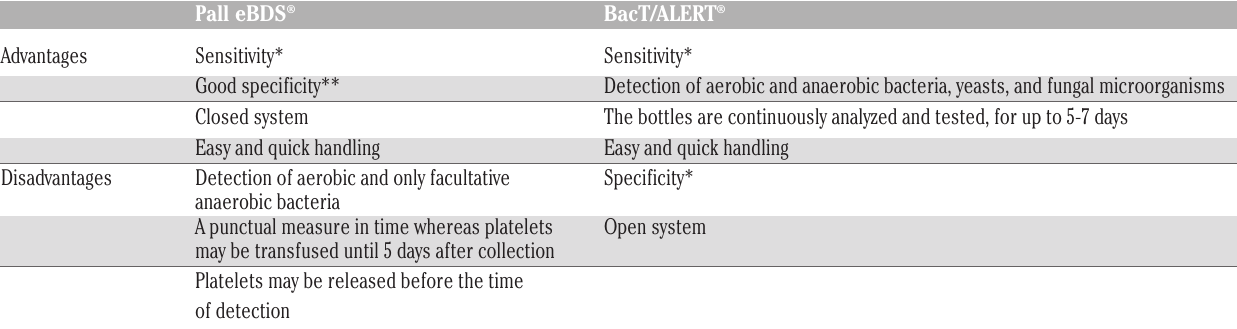
Table 1. A comparison of the advantages and disadvantages of BacT/ALERT ® and Pall eBDS ® , according to the data reported by Schmidt et al. 4 The sensitivity, efficiency and manageability of BacT/ALERT ® and Pall eBDS ® were compared in a multicenter-study carried out in 4 German centers. It concerned 6,307 pooled platelets and 4,730